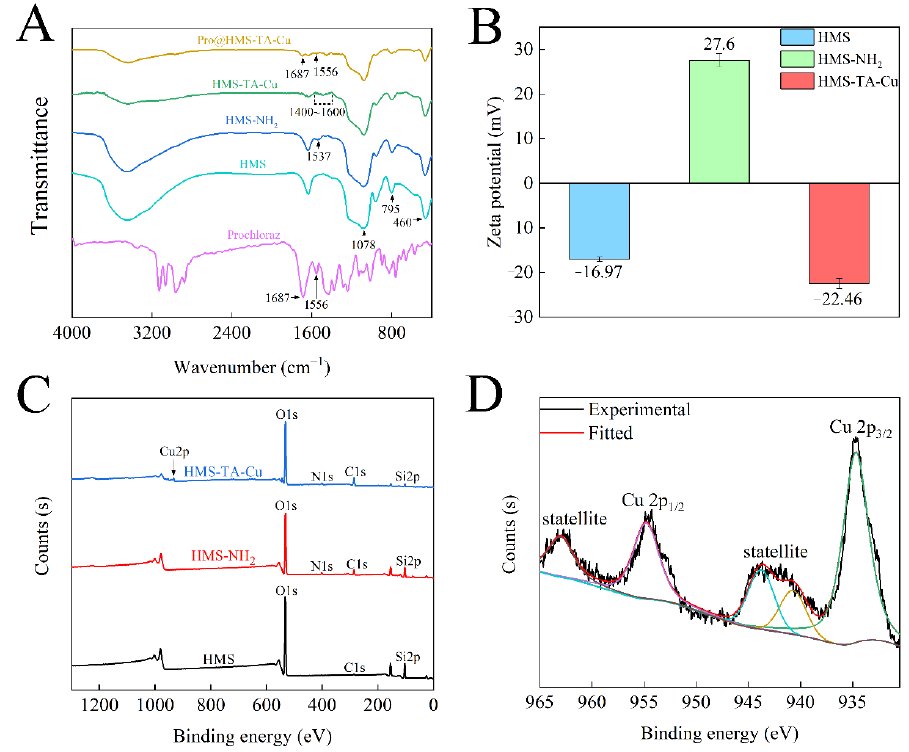
Figure 3. FTIR spectra of prochloraz, HMS, HMS-NH 2 , HMS-TA-Cu and Pro@HMS-TA-Cu ( A ); Zeta potential ( B ) and XPS spectra ( C ) of HMS, HMS-NH 2 and HMS-TA-Cu; curve fitting of Cu 2p peak of HMS-TA-Cu ( D ).